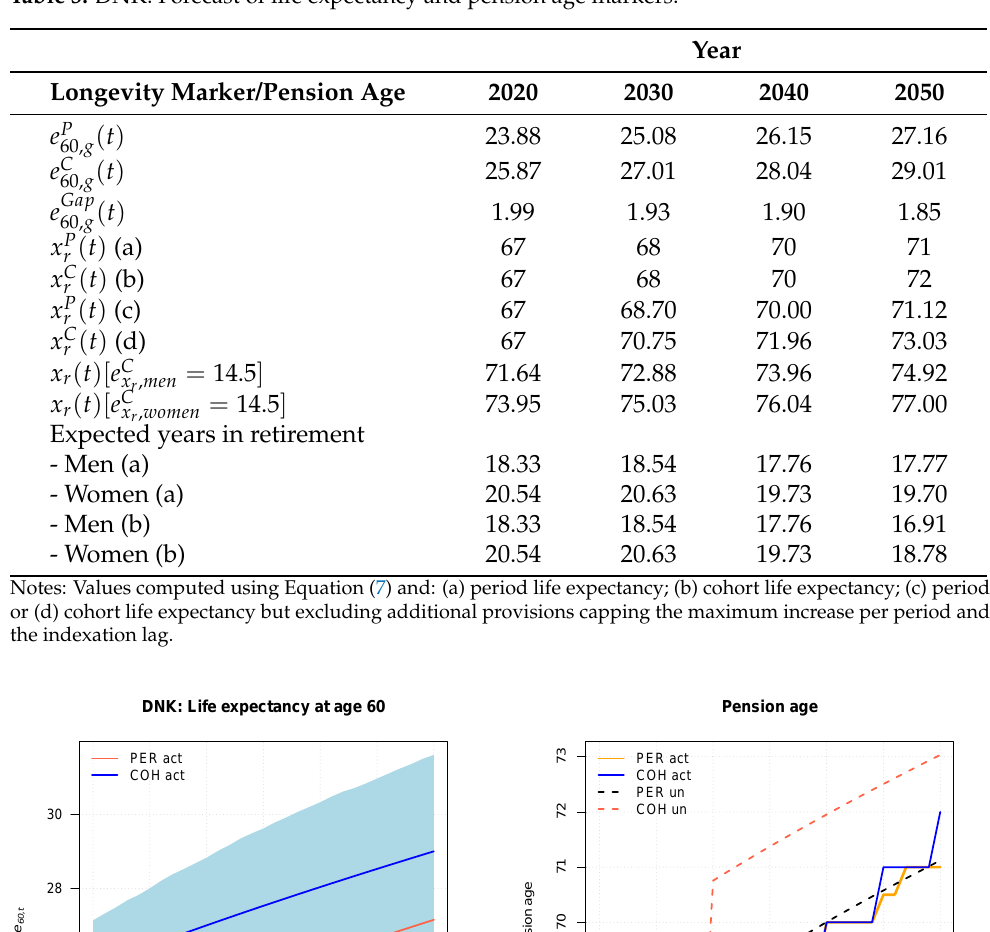
life expectancy is used in the indexation rule (right panel, solid lines). The dashed lines keep their previous meaning. Numerical values for selected years are provided in Table 3. Table 3. DNK: Forecast of life expectancy and pension age markers.